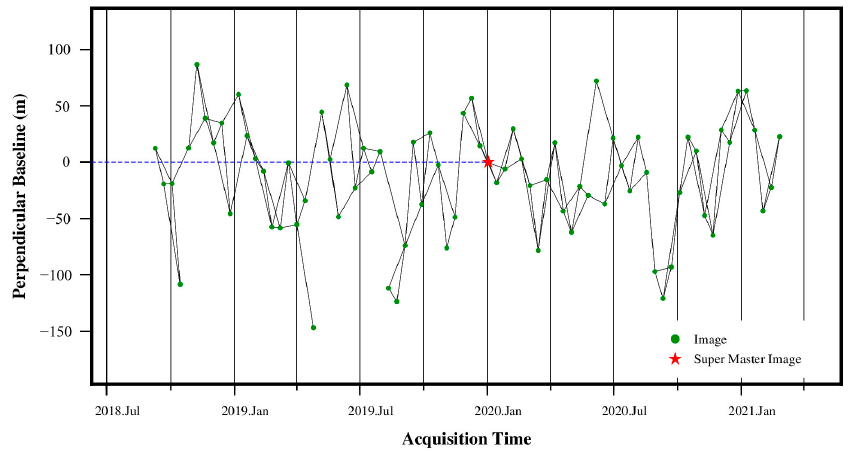
Figure 8. Temporal and spatial baseline of interferogram pairs.